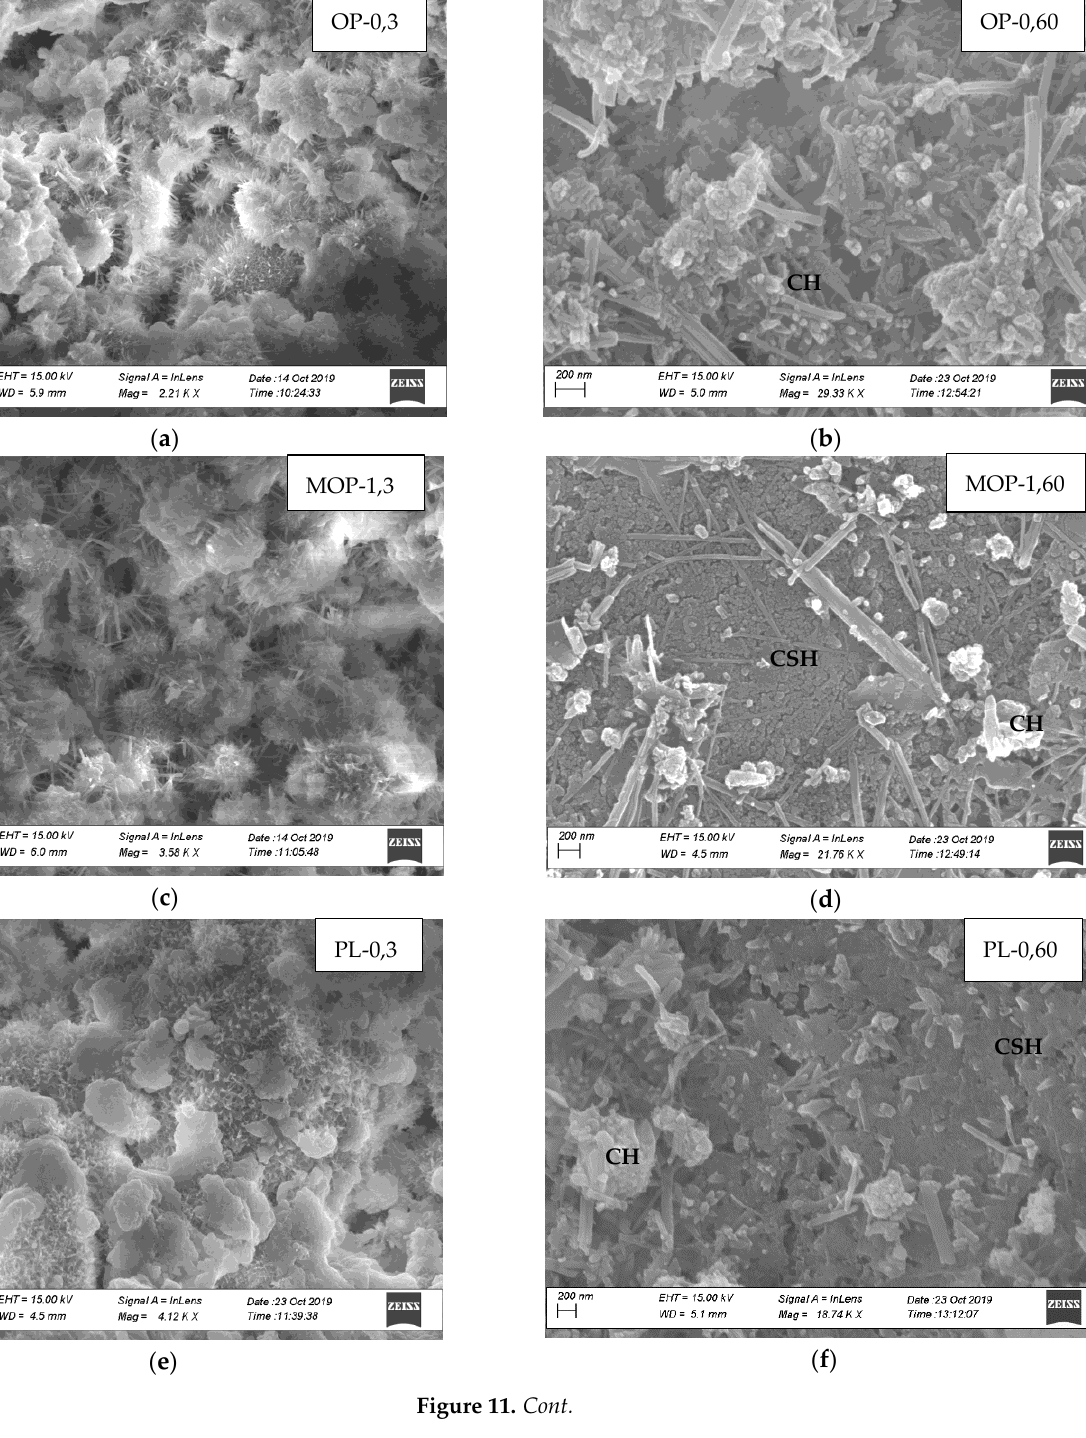
( h ) Figure 11. ( a ) Microstructure of OPC at 3 days, ( b ) Microstructure of OPC at 60 days, ( c ) Microstructure of OPC replaced with 1% nano CaCO 3 at 3 days, ( d ) Microstructure of OPC replaced with 1% nano CaCO 3 at 60 days, ( e ) Microstructure of PLC at 3 days, ( f ) Microstructure of PLC at 60 days, ( g ) Microstructure of PLC replaced with 1% nano CaCO 3 at 3 days, ( h ) Microstructure of PLC replaced with 1% nano CaCO 3 at 60 days. For OPC, at three days (Figure 11a,c), the ettringite crystals for MOP-1 are much larger as compared to OP-0, indicating a rapid increase in hydration rate at the early ages that might have resulted in higher early compressive strength and reduced final set time. Further, at 60 days of hydration (Figure 11b,d), the SEM image for MOP-1 shows a more compact structure as compared to OP-0, contributing to a denser structure, thus improv- ing the permeability and later age strength of the concrete. This phenomenon could also explain reduced chloride permeability, reduced ASR expansion, and improved scaling re- sistance of concrete with nano CaCO 3 . Similarly, for PLC, at 3 days (Figure 11e,g), the SEM image for PL-0 has more unhy- drated products (as indicated by white fluffy structures) as compared to MPL-1. Also, the ettringite crystals are longer in MPL-1, indicating an increased hydration rate, thus result- ing in a reduced final set time. Additionally, for 60 days (Figure 11f,h), the SEM images for both samples show compact structure but with more hydration products embedded in CSH for MPL-1, thereby improving the later age strength and permeability of PLC con- crete. 4. Conclusions To make Portland cement environment-friendly and economical, limestone powder is incorporated during the manufacture of cement. This cement type, called PLC (Portland Limestone Cement), has environmental benefits due to the reduced clinker production